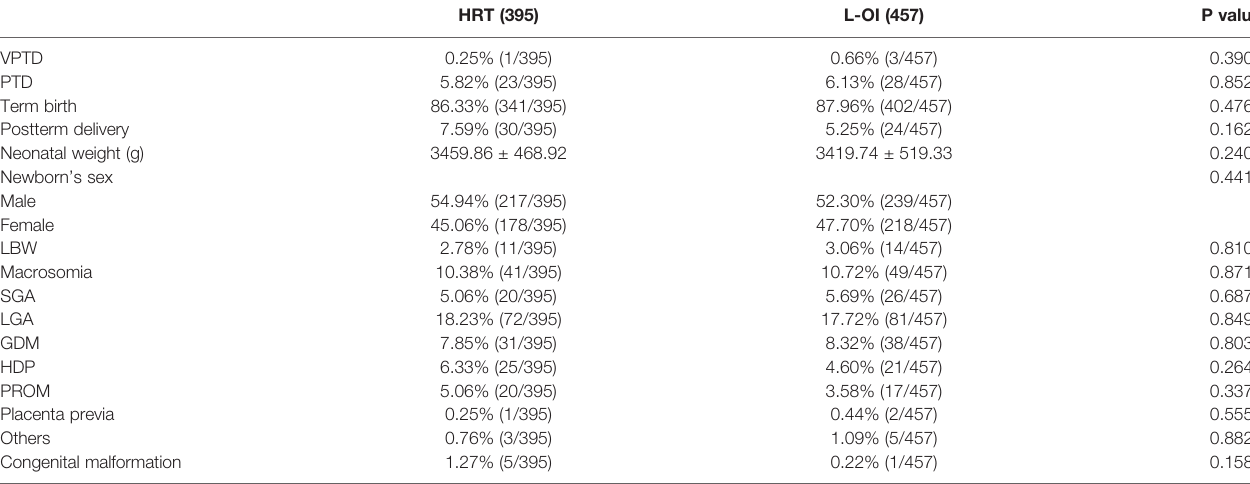
TABLE 6 | Perinatal and neonatal outcomes of singleton live